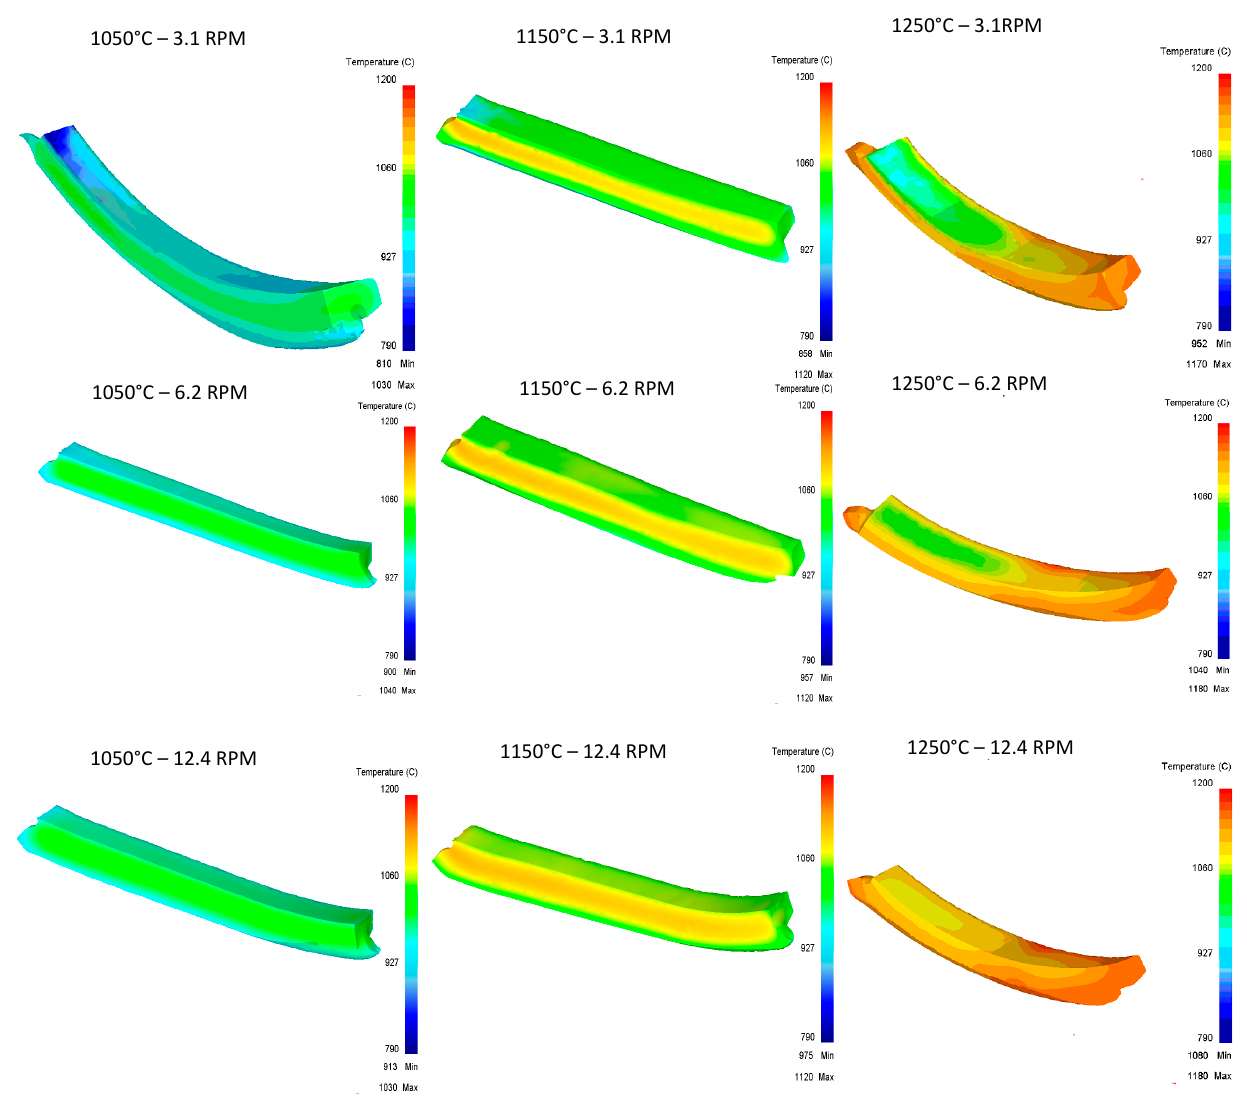
Figure 12. Upper Rail temperature graph for first pass.